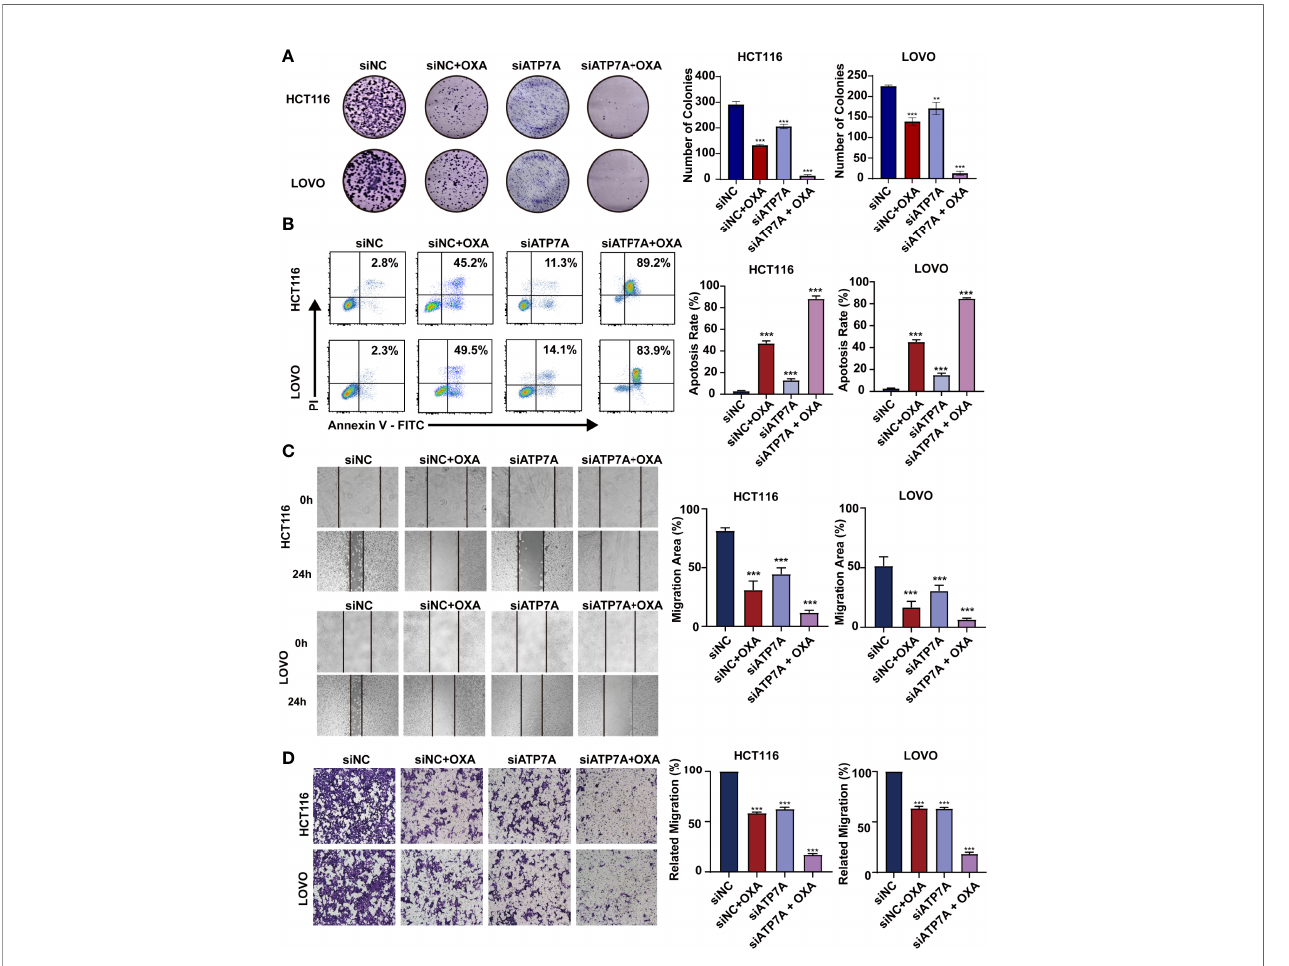
FIGURE 3 | Knockdown of ATP7A expression may inhibit cancer tumorigenesis in vitro (A) Colony formation assays in HCT116 and LOVO cells. (B) A fl ow cytometer was performed to assess the apoptosis rate of HCT116 and LOVO cells. (C) Wound healing assay of HCT116 and LOVO cells. (D) Transwell assay was performed to evaluate the invasion of HCT116 and LOVO cells. **P < 0.01 and ***P < 0.001 when compared to the control